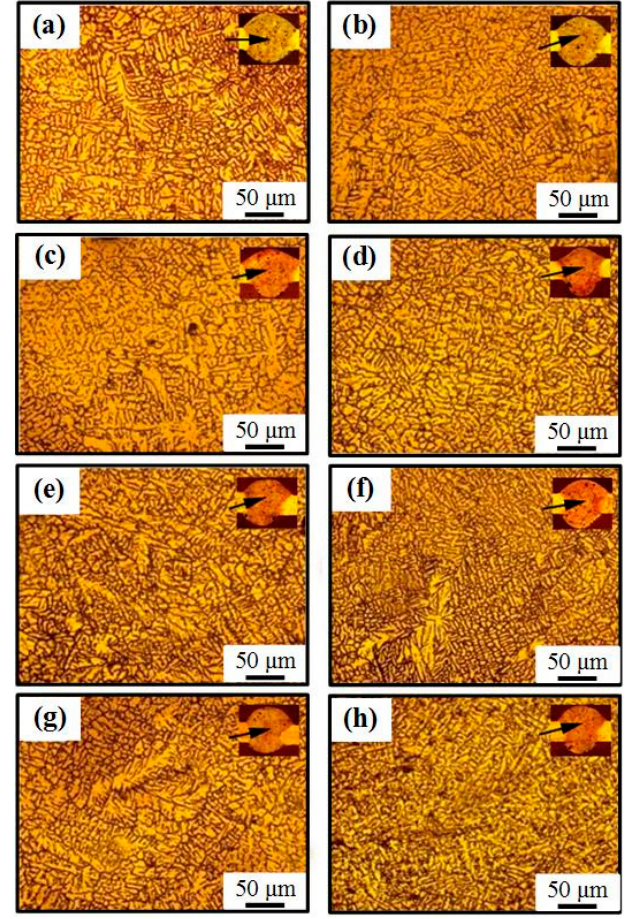
Figure 7. ( a – h ) The optical microstructure of WM welded by ( a ) AC CMT and ( b ) AC CMT coupled current at frequency of 20 kHz, ( c ) 30 kHz, ( d ) 40 kHz, ( h ) 50 kHz, ( e ) 60 kHz, ( f ) 70 kHz, and ( h ) 80 kHz, respectively.